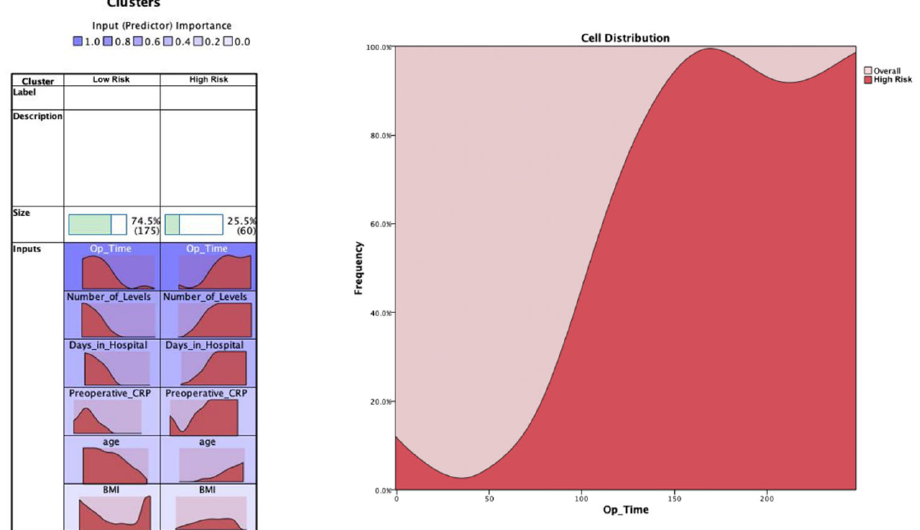
Figure 1. K-means cluster analysis for the raw hospital length of stay target variable (continuous scale). The most important feature to classify the data was the operation time, followed by the number of levels, LOS, preoperative CRP, age, and BMI. The distribution charts show the distribution of the features for both clusters. An example feature (operation time) is shown to help interpretation. The selected feature shows that the distribution of operation time is right-shifted for the high risk cluster, whereas it is left-shifted for the low risk